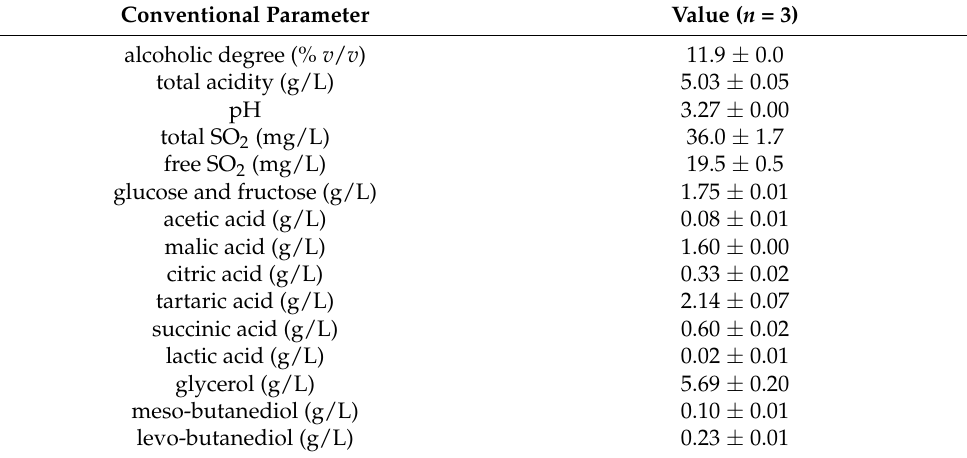
Table 1. Enological conventional parameters of the Verdejo wine before bottling. Conventional